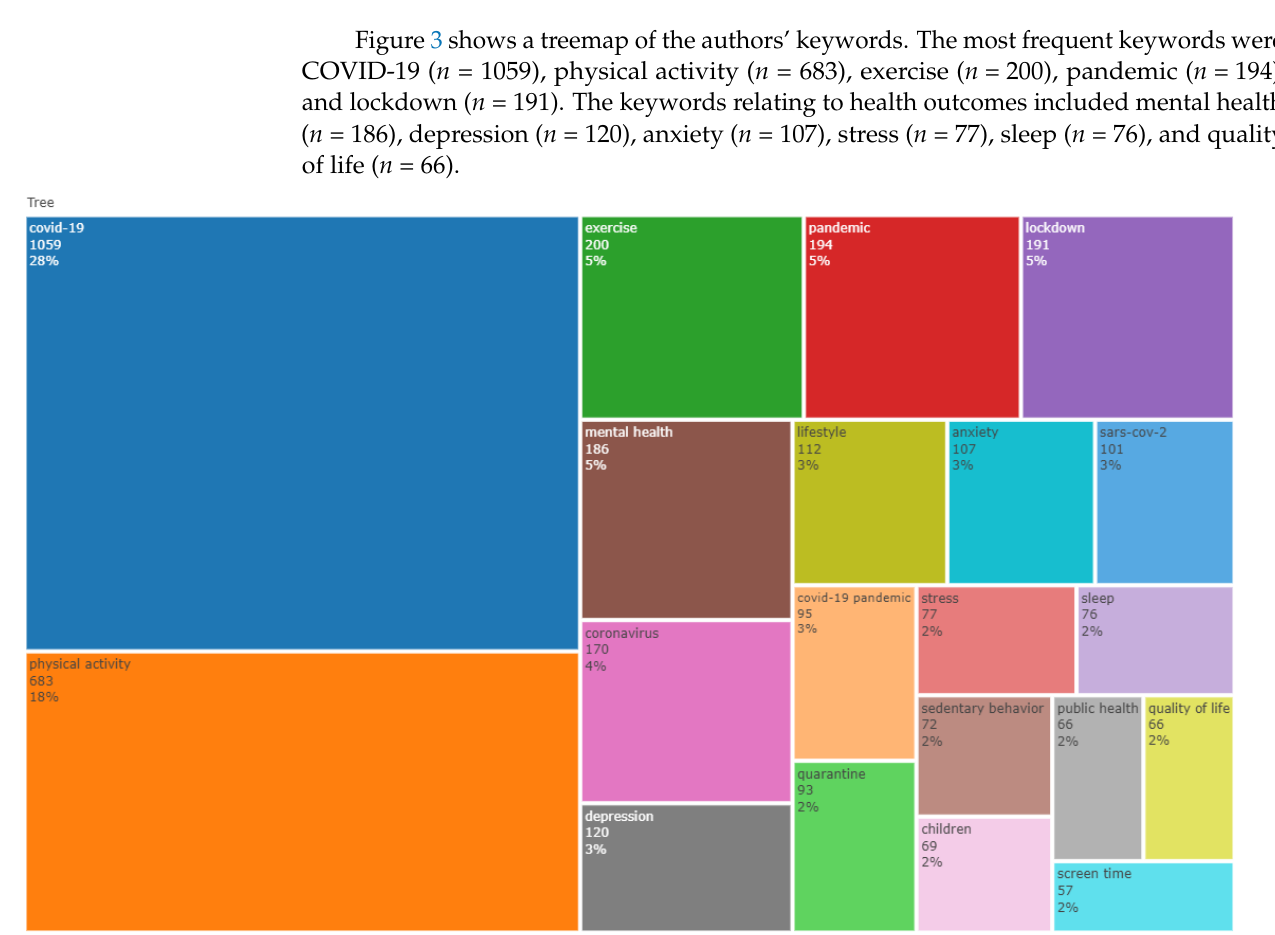
Figure 4. Co-occurrence network using author ’ s keywords (Louvain algorithm) .